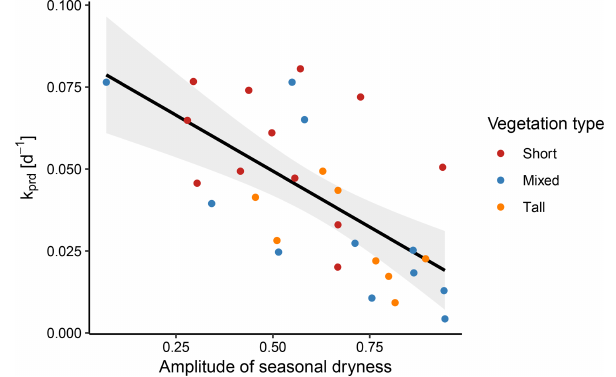
Figure 9. Fraction of radiation-associated evapotranspiration (ET frac ) as a function of S rem . Points represent daily values for all dry-down events, and the red line is the mean response for all events derived with a linear regression ( p < 0 . 001).